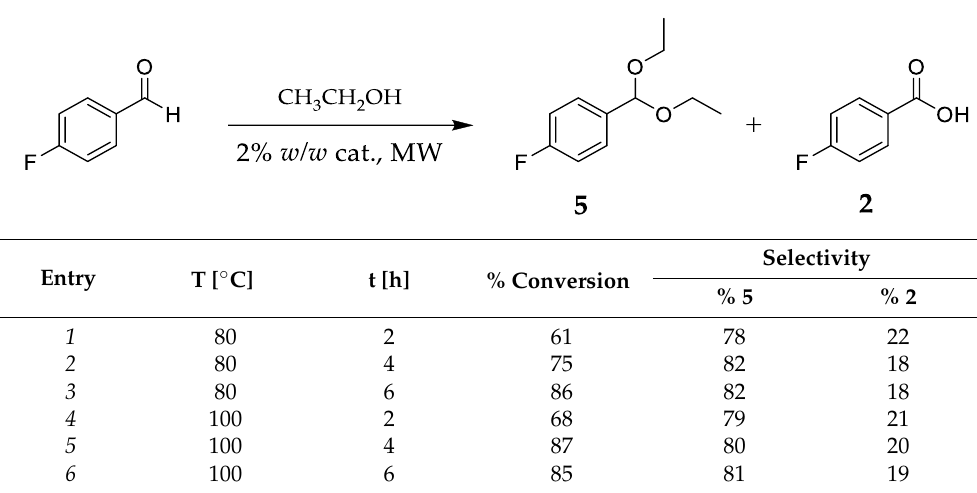
Table 9. Optimization of the reaction conditions using ethanol as solvent a .